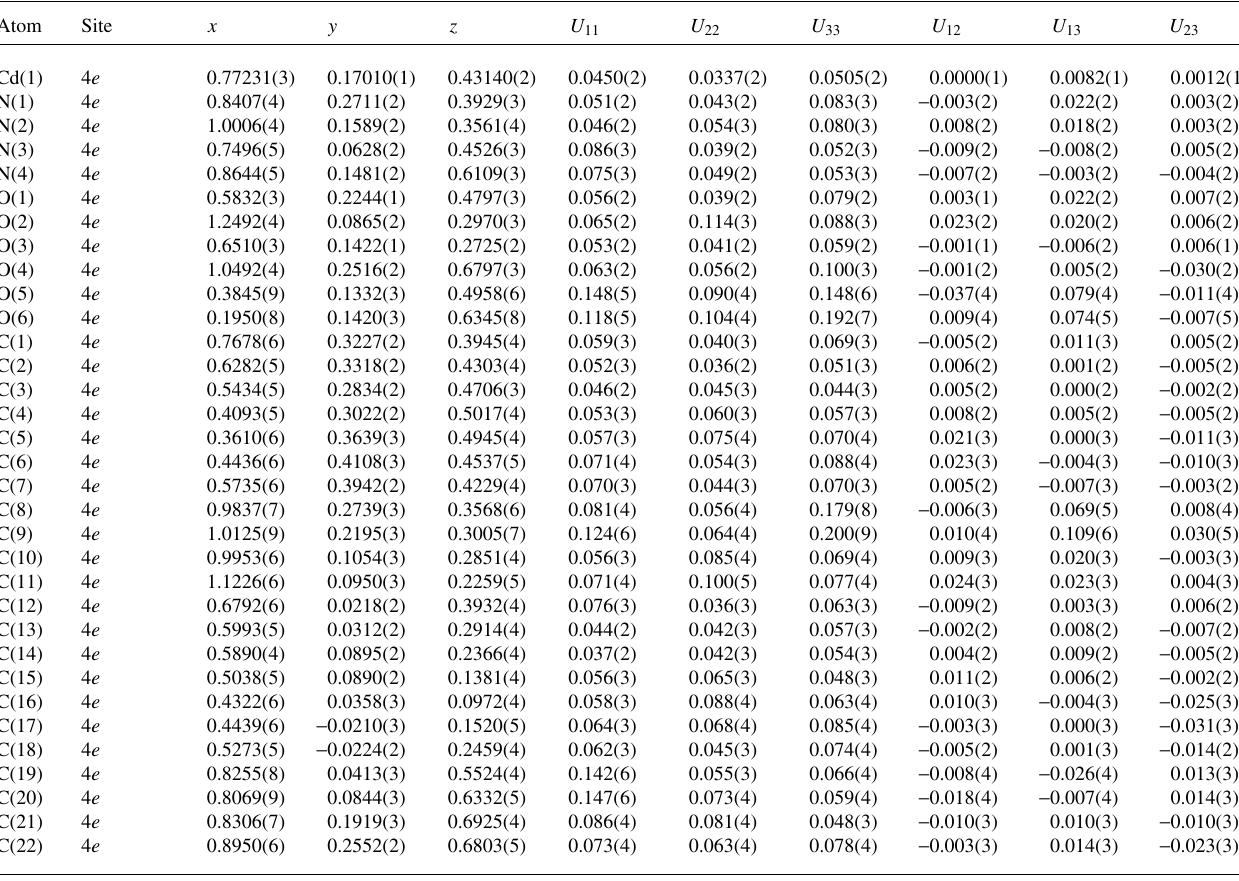
Table 3. Atomic coordinates and displacement parameters (in Å 2 )